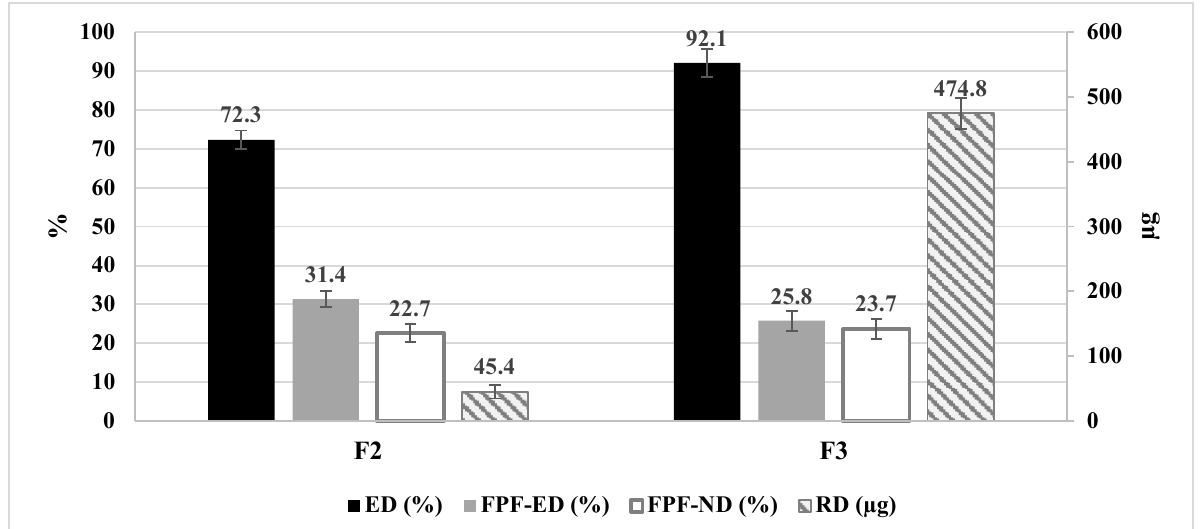
Figure 10. Aerodynamic performance of TQ-containing nanoparticles, highlighting the main parameters for formulations F2 and F3. ED: emitted dose; FPF-ED: fine particle fraction of emitted dose; FPF-ND: fine particle fraction of nominated dose; RD: respirable dose. Results are presented as means ± SD, n = 3.